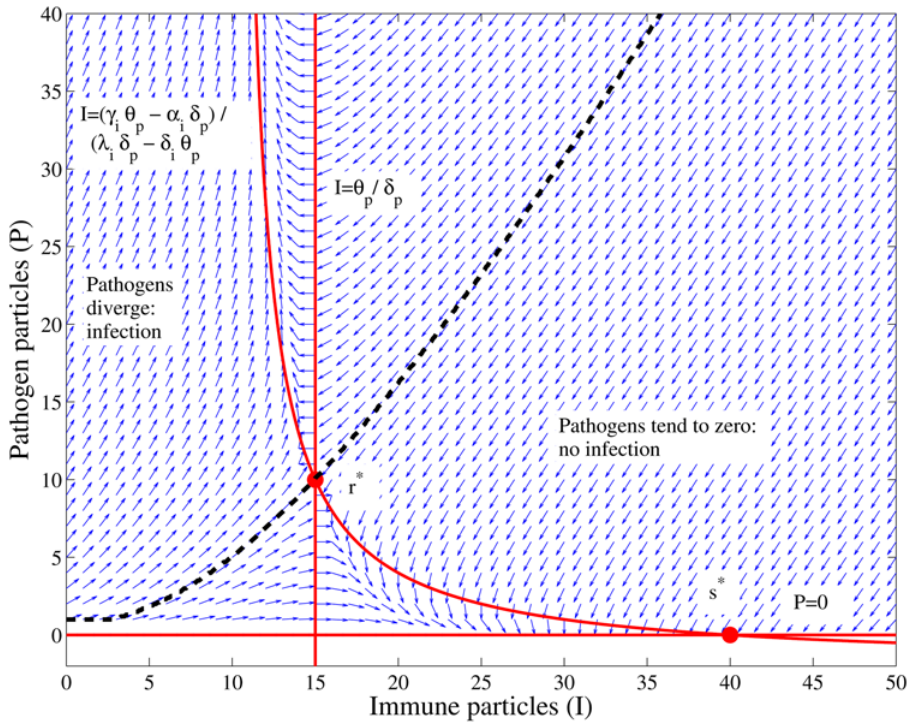
Figure 3. Vector field plot of the deterministic cumulative dose model for a characteristic parameter set h P , d P , a I , ª I , d I , l I f gf g ~ 0 : 15 , 0 : 01 , 0 : 4 , 0 : 01 , 0 : 005 , 0 : 05 f gf g . To avoid overlaps of the vectors they have been normalized. The solid red lines are the nullclines, the intersections of the nullclines are the fixed points s (cid:1) (stable pathogen elimination equilibrium) and r (cid:1) (unstable saddle point equilibrium). The dash black line is the separatrix that separates those configurations that will go to non-infection equilibrium, s (cid:1) , and those that will diverge in the number of pathogens resulting on infection. The separatrix has been calculated numerically.